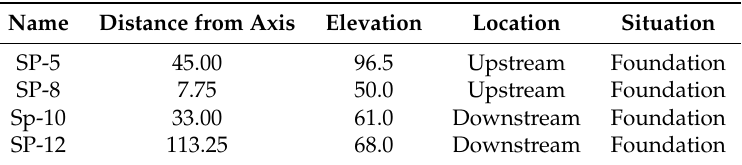
Table 2. Characteristics of Piezometers and Casagrande Piezometer installed in Section #2 of Boostan Dam.